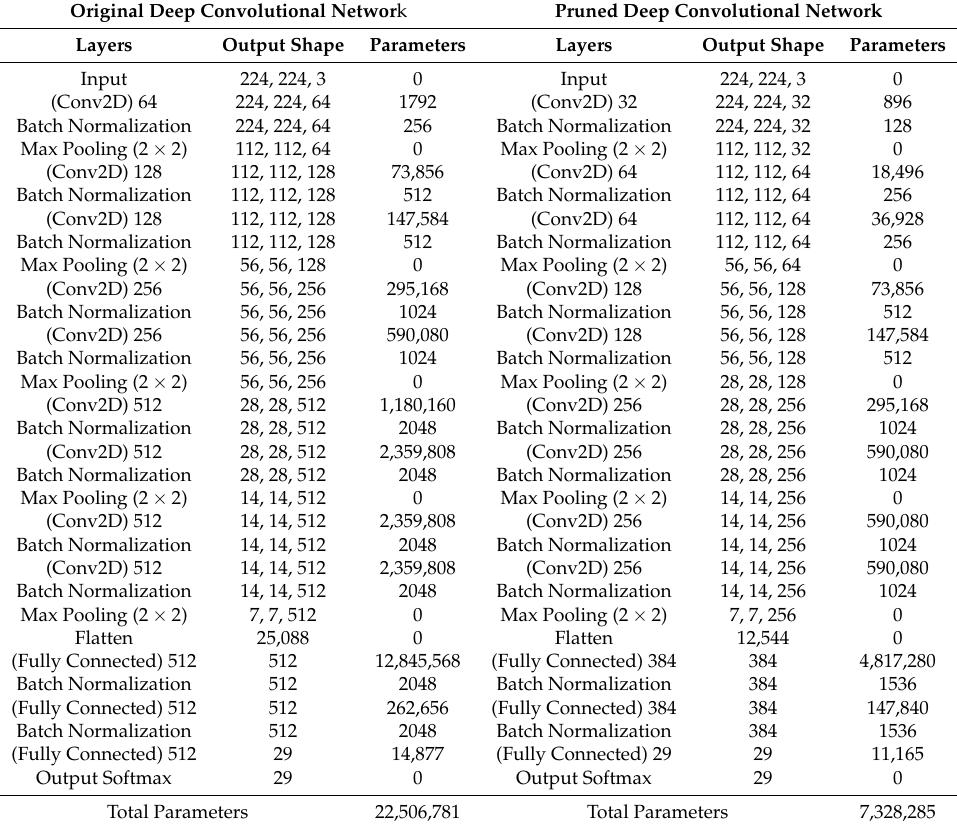
Table 1. Parameters in the proposed deep convolutional network and pruned deep convolutional